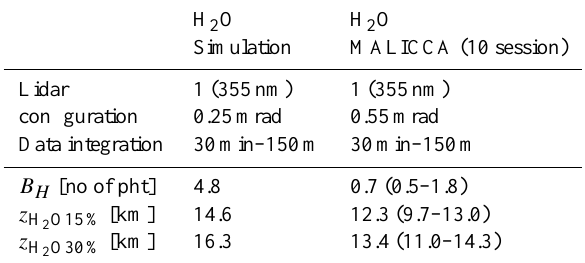
Table 4. Comparison of the MAIDO-H 2 O capabilities estimated by the numerical simulation of Hoareau et al. (2012) and calculated as the mean of ten nighttime measurements acquired during MAL- ICCA. The minimum and the maximum values (in the brackets) of the measured parameters are also reported. H 2 O